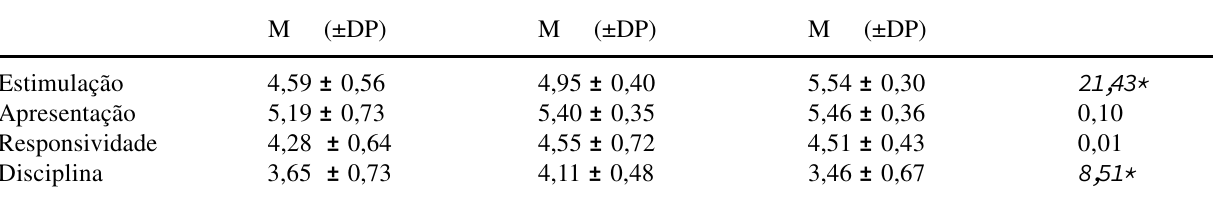
Correlações entre os Dados Sociodemográficos e os Fatores do Inventário sobre Crenças e Práticas Maternas no Grupo de Mães da Zona